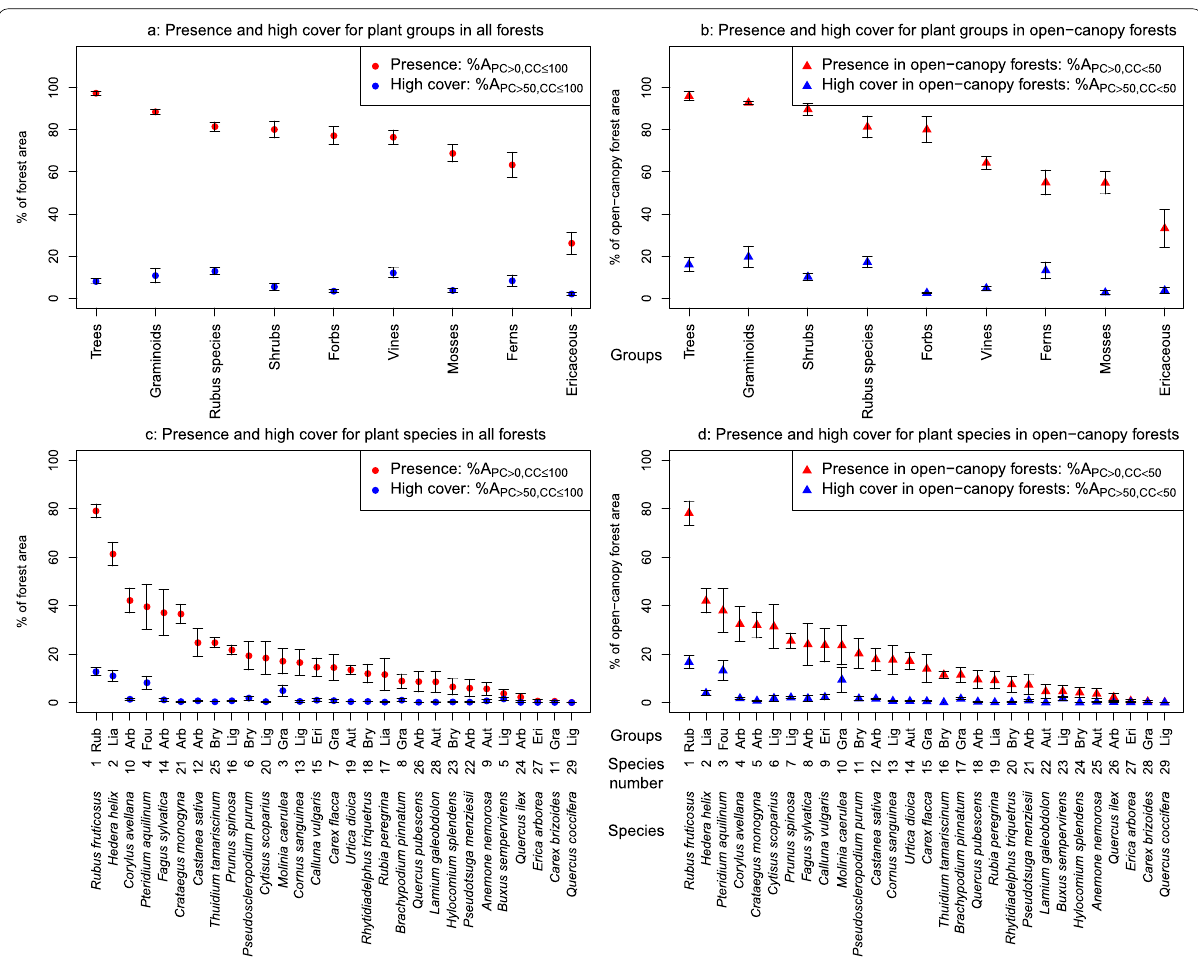
Fig. 4 NFI indicators (mean standard error) across the five regions: indicator of plant presence and of plant high cover in all forests, % A PC > 0, CC ± PC > 50, CC ≤ 100 ( a and c ), and indicator of plant presence and of plant high cover in open‑canopy forests, % A PC > 0, CC < 50 and % A PC > 50, CC < 50 ( b and d ), for ( a and b ) plant groups and ( c and d ) plant species, respectively. In each graph, species and groups are ranked by decreasing order of ( a and c ) % A PC > 0, CC values or ( b and d ) % A PC > 0, CC < 50 values. Please note that the scale of the y‑axis changes between the ≤ 100